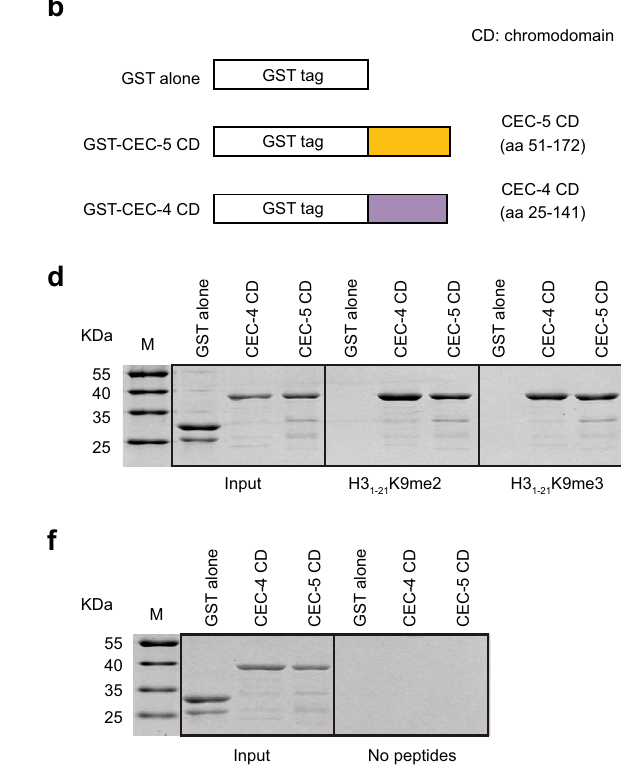
The CEC-4 chromodomain was used as a positive control. c H3 (1-21) K9me0 (middle) and H3 (1-21) K9me1 (right). d H3 (1-21) K9me2 (middle) and H3